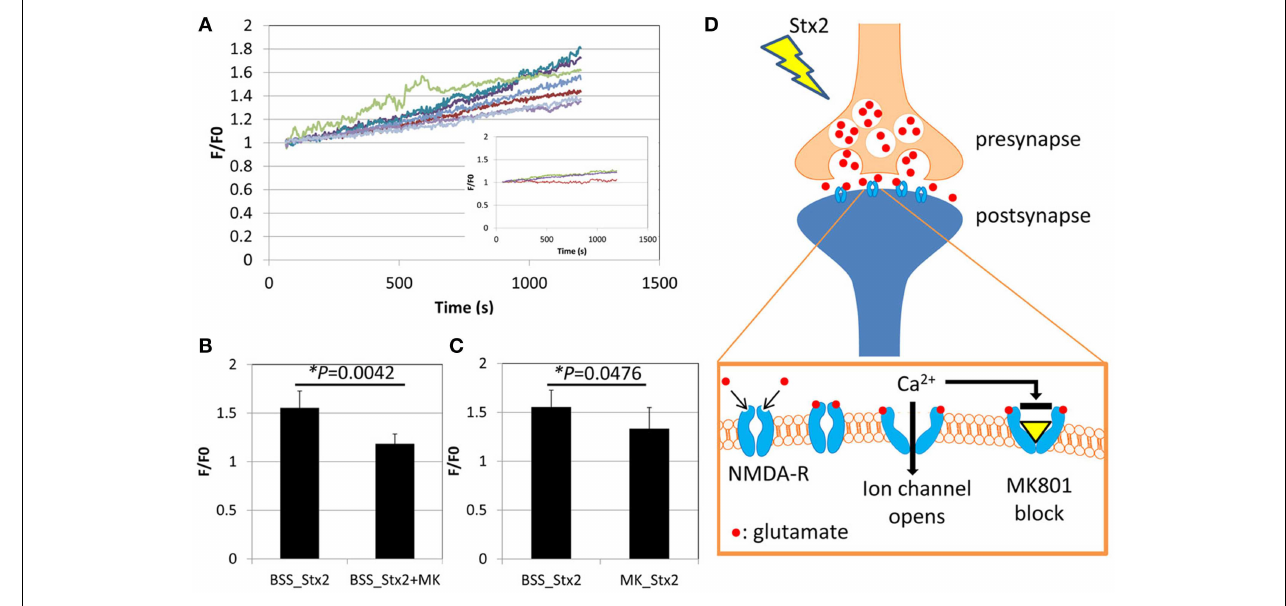
(F) was divided by F0 to calculate fold change (F/F0) and plotted. An inset shows traces of control neurons without Stx2. (B) Stx2 alone ( n = 7 ) and Stx2 + MK ( n = 4 ) added samples were compared their final F/F0 values at 1200s. (C) Cells were incubated with ( n = 9 ) or without ( n = 7 ) MK and recorded as in (A) and analyzed as in (B) . In (B,C) , Student’s t -test was performed. (D) A schematic presentation of Stx2-induced glutamate release and affected NMDA receptor. Glutamate is secreted from presynapse and binds to NMDA-receptors by which Ca 2 + channels open, causing influx of detectable Ca 2 + . MK-801 binds to opened channel to block Ca 2 +